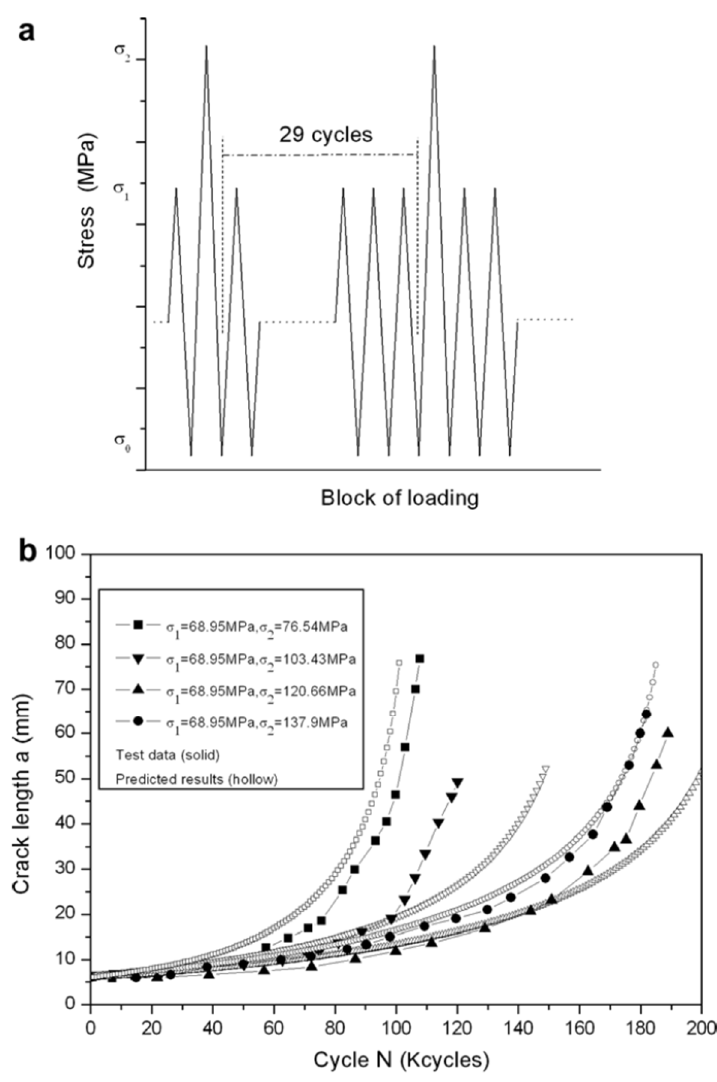
Figure 22. Comparison of AL7075-T6 test data [43]. ( a ) loading blocks; ( b ) comparison of predicted model with experimental data.